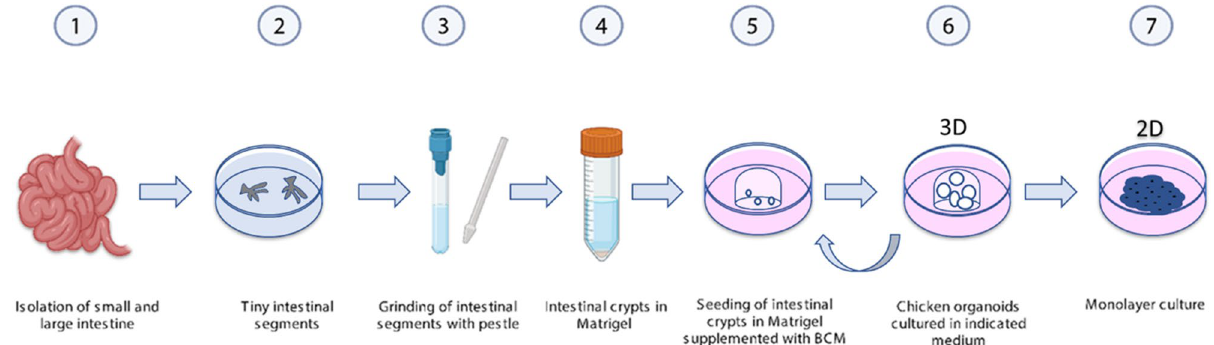
Figure 1. Schematic overview of the isolation and culture conditions of chicken intestinal organoid. (1) Isolation of small and large intestines (2) Intestinal tissue was cut into tiny segments and washed with PBS- EDTA. (3) To obtain a homogenous suspension, segments were minced using a Potter–Elvehjem PTFE pestle and glass tube. (4) After multiple centrifugation steps, the pellet was resuspended in ice-cold Matrigel (5) and seeded in a culture plate (6) . After polymerization of Matrigel, crypts were cultured with indicated media as defined in supplementary Table 1. (7) Monolayer cultures were obtained from three-dimensional and large intestines were collected and pooled from three chicken embryos post-mortem , and repeated three times. This method was conducted in accordance with protocols approved by the Department of Biomolecular Health Sciences, Division of Infectious Diseases & Immunology of the Utrecht University. Although according to European legislation for the protection of animals used for scientific purposes (Directive 2010/63/EU) experi- ments with embryonated chicken eggs are not considered animal experiments. The study was carried out in compliance with the ARRIVE guidelines. Immediately after collection, the intestines were placed in a petri dish containing 10 mL of 5 mM ice-cold phosphate-buffered saline-ethylenediaminetetraacetic acid (PBS-EDTA; Lonza, Basel, Switzerland). After wash- ing with PBS-EDTA, the intestines were cut into small segments and placed into a 50 mL conical tube containing PBS-EDTA. To get a homogenous suspension of intestinal crypts, 2 mL of PBS-EDTA containing intestinal seg- ments was minced using a potter–elvehjem PTFE pestle and glass tube (Sigma-Aldrich). The intestinal crypts’ suspension was collected in a 15 ml tube and centrifuged at 295× g for 5 min at 4 °C. After centrifugation, the supernatant was discarded and crypt aggregates were resuspended in 10 mL PBS-EDTA and centrifuged again. This was repeated up to 5 times until supernatants free of floating particles. Next, the crypts’ suspension was filtered through a 100-µm cell strainer (Corning, Amsterdam, the Netherlands) to get a uniform intestinal crypt solution. The filtrate was centrifuged at 295× g for 5 min at 4 °C and supernatant was discarded. The pellet was resuspended in 800 µL of ice-cold Matrigel (Corning; 354234). Two drops of 25 µL intestinal crypts-matrigel suspension, containing 25–50 crypts, were added per well in a pre-warmed 12-well culture plate (Corning). Following polymerization of Matrigel, 2 mL of organoid media (as indicated) was added per well and the cul- ture plate was placed at 41 °C, 5% CO 2 , which is the optimal temperature to culture chicken cells, to mimic the body temperature of the chicken (Fig. 1). 3D intestinal organoids were passaged twice a week in a 1:4 ratio, by dissociating the organoids embedded in Matrigel drops in 1 mL fresh BCM through vigorous pipetting. After dissociation, the organoid solution was centrifuged at 295× g for 5 min at 4 °C. Supernatant was discarded and the organoids pellet was suspended in ice-cold Matrigel for seeding to expand the 3D intestinal organoids culture. Isolation of mouse intestinal crypts. The mouse intestinal crypts were isolated from the ileum as reported previously 23 . A female mouse C57/BL6, 6 months of age was sacrificed using carbon dioxide. The use of mouse intestine was approved by the local committee for care and use of animals at Utrecht University and all experiments were performed in accordance with the relevant guidelines and regulations. Only one surplus mouse was used for this study. The study was carried in compliance with the ARRIVE guidelines. Villi were removed from the ileum, by scraping with a scalpel and the tissue was cut into small pieces, trans- ferred to a tube with ice-cold PBS and washed three times with PBS (spun down at 295× g for 5 min between every wash step). Crypts that were isolated from the villi were resuspended in Matrigel, containing 25–50 crypts/25 µL, and two drops of 25 µL suspension were added to each well. The organoids were kept in ICM for 3 days, and medium was subsequently replaced with MOCM to stimulate organoid formation. These organoids were pas- saged once a week in a 1:4 ratio, containing 25–50 organoids/well, by dissociation of the organoids embedded in Matrigel drops in 1 ml fresh BCM through vigorous pipetting. After dissociation, the organoid solution was centrifuged at 335× g for 5 min at 4 °C. Supernatant was discarded and the organoids pellet was resuspended in ice-cold Matrigel for seeding to expand the 3D intestinal organoid culture. Conversion of 3D intestinal organoids to monolayer culture.